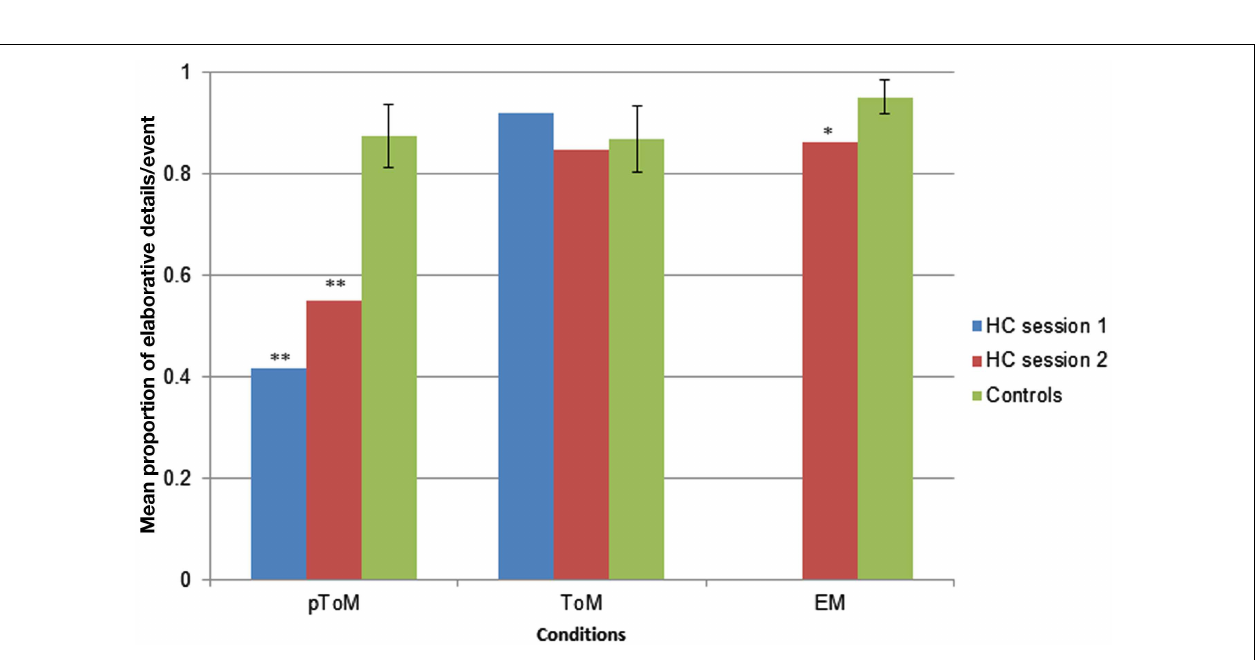
FIGURE 2 |The mean proportion of elaborative-to-total-number of internal details provided by H.C. and controls in response to each pToM,ToM, and EM event, * p < 0.01; ** p < 0.0001. Error bars indicate standard